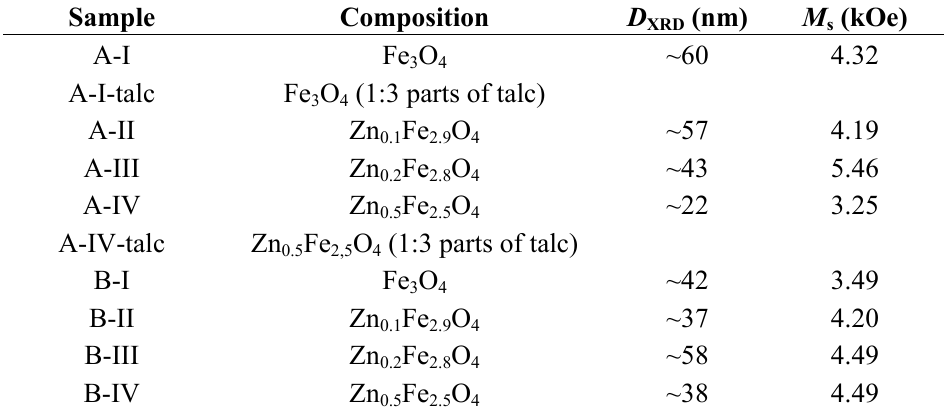
: average grain size XRD -saturation s